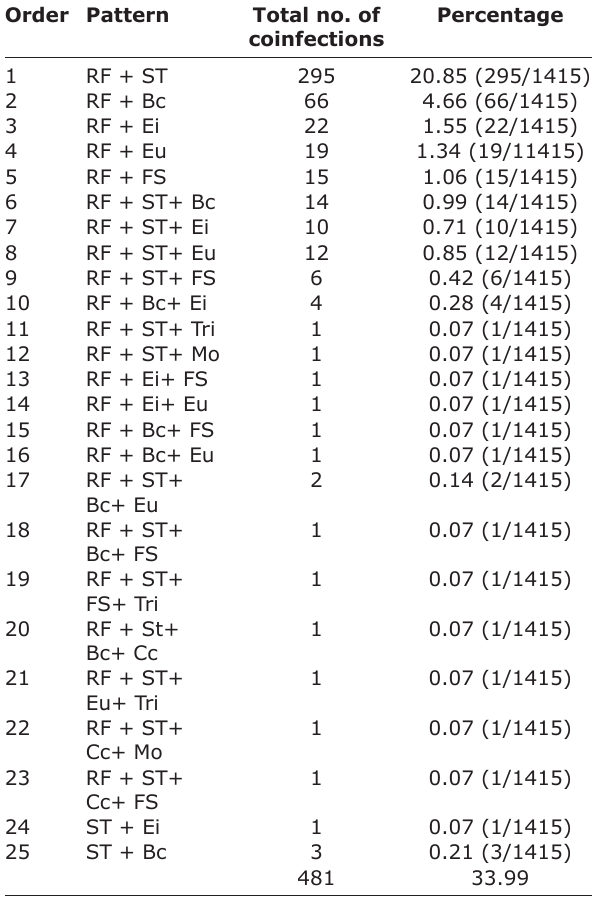
Table-2: Coinfection patterns of gastrointestinal parasite positive in fighting bulls (1415 samples). Order Pattern